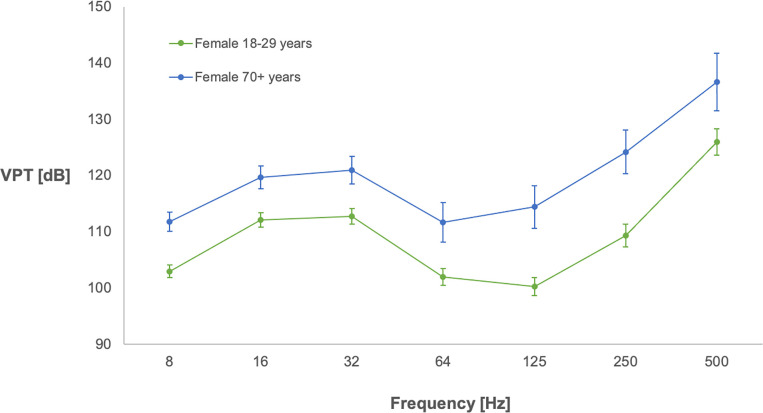
Vibration perception thresholds for index finger measured in females of two age groups.Y-axis shows mean vibration perception threshold (VPT) values in decibels (dB: relative 10−6 m/s2), and 95% confidence intervals, for the seven different frequencies (Hz) presented in the X axis. Subjects were females between 18 and 29 years (n = 58), as well as females over 70 years (n = 30).